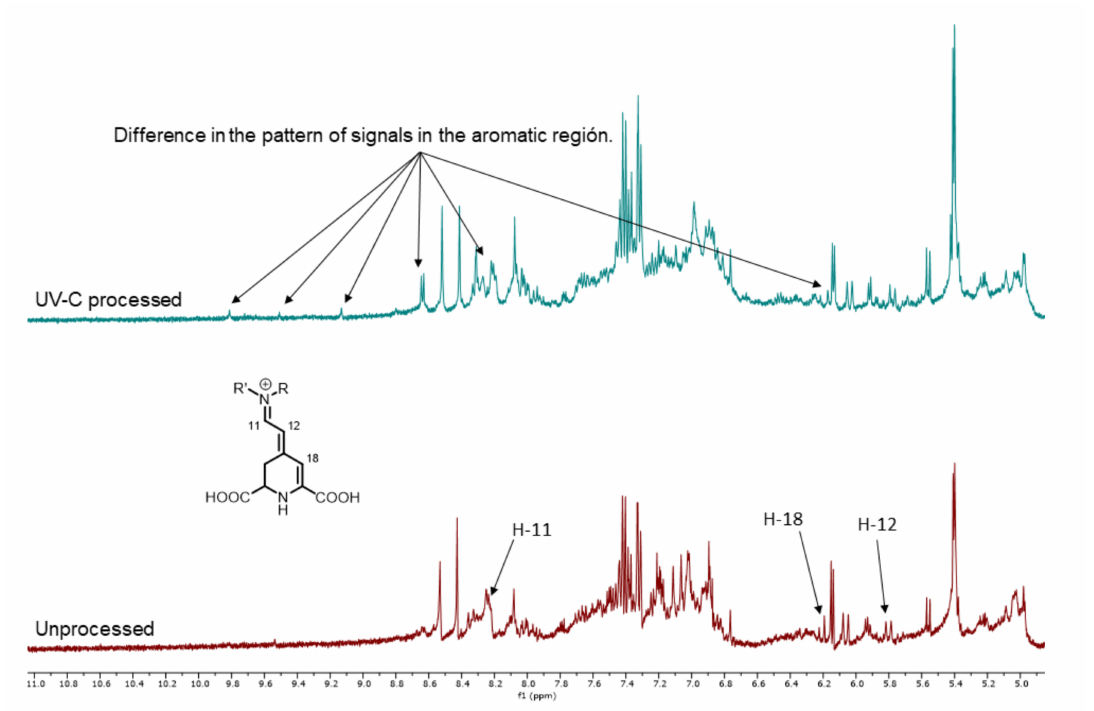
Figure 4. 1 H NMR (400 MHz, D 2 O) expansion on the aromatic region in spectra for UV-C processed (dose 16.5 ± 0.21 mJ / cm 2 and pH 3.5) and unprocessed (pH 3.5)